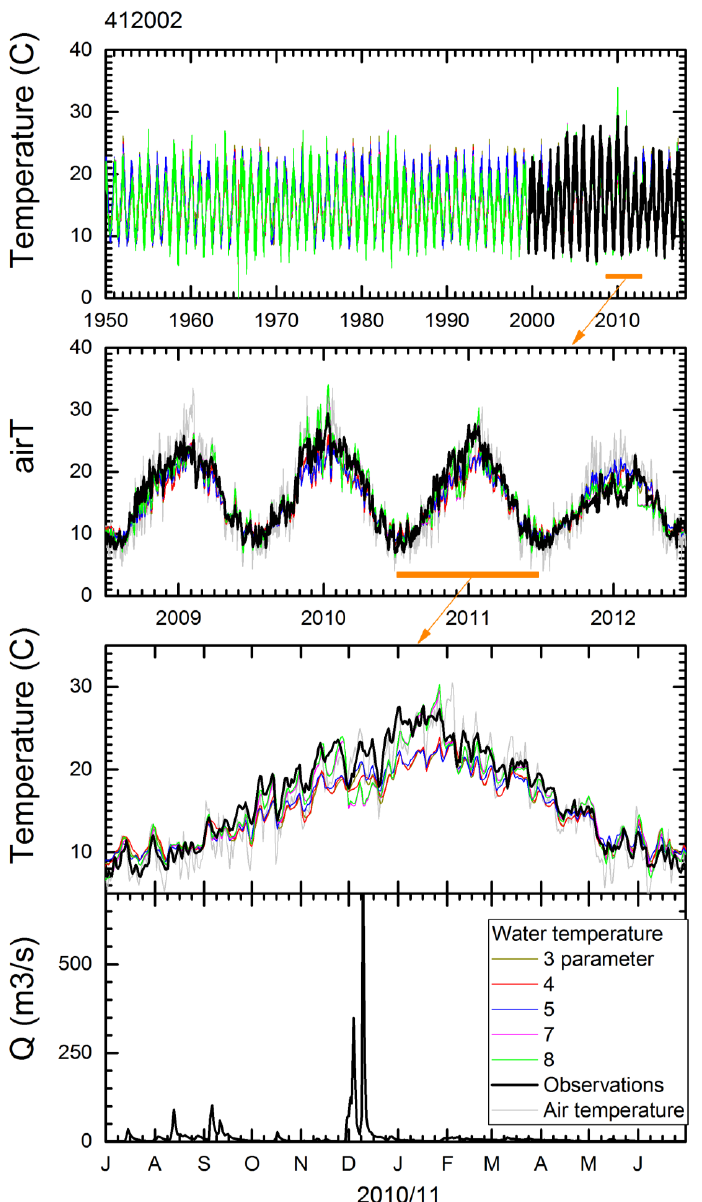
Figure 4. Observed and simulated stream temperatures using different model parameterisations and flow rate for Station 412002 (Lachlan River at Cowra). Observations (black lines), simulations (coloured lines), air temperature (grey lines). Top panel is the entire simulation period followed by a four-year period and a close view of the seasonal cycle in 2010/2011, with zoom ranges depicted by orange bars and arrow. The bottom panel shows flow rates during this year.